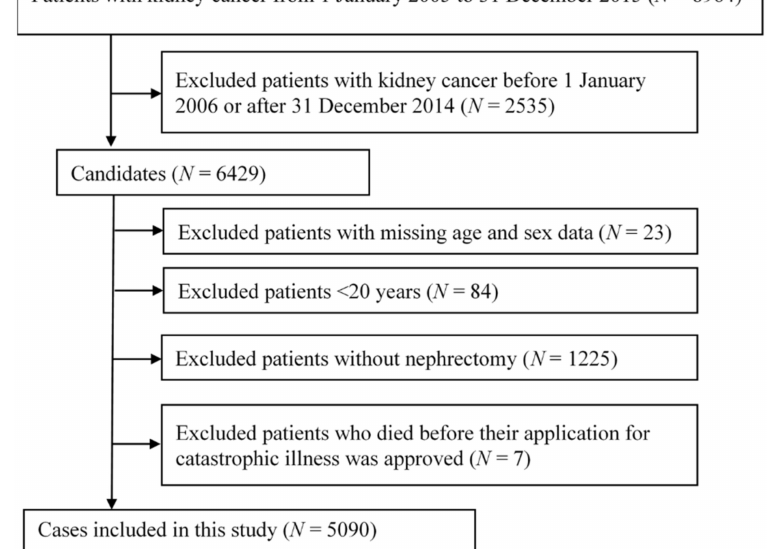
Figure 1. Selection criteria and process for eligible